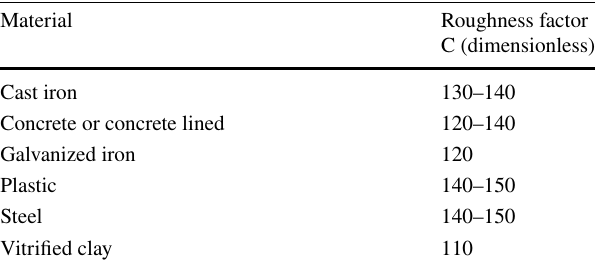
Table 1 Resistance coefficients for the Hazen–Williams